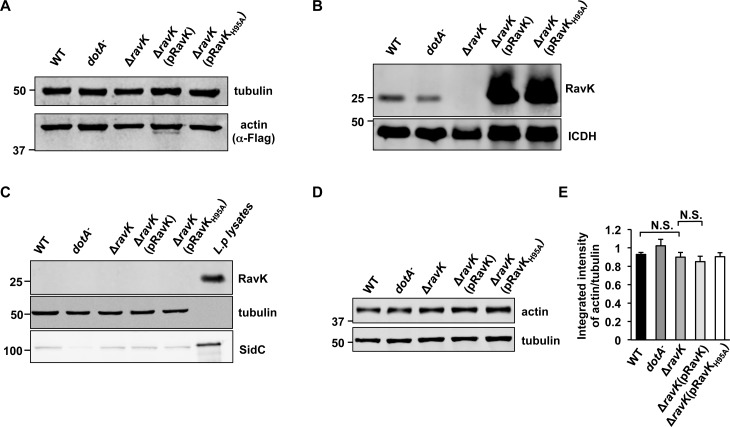
RavK-mediated cleavage of actin occurs during L. pneumophila infection.A. Actin is cleaved by translocated RavK during bacterial infection. Cells expressing Flag-tagged actin were infected with relevant L. pneumophila strains for 2 h and cleared cell lysates was probed by immunoblotting with a Flag specific antibody. Tubulin was probed as a loading control. Similar results were obtained from five independent experiments and a representative blot was shown. B. The detection of RavK expression in L. pneumophila. The lysates of WT and the dotA- mutant were from exponentially grown bacteria whereas those of other strains were from bacteria grown at the post-exponential phase; the metabolic enzyme isocitrate dehydrogenase (ICDH) was probed as a loading control. C. RavK cannot be detected in saponin-soluble fractions of infected cells with RavK-specific antibody. SidC, a known Dot/Icm substrate was probed as a positive control for translocation and tubulin was probed as a loading control. D. Cleavage of endogenous actin. Lysates of cells similarly infected as described in C were probed for actin with tubulin as a loading control (left panel). E. The ratio of intensity between the bands representing actin and tubulin was quantified from three independent experiments. Note that a reduction in actin was not observed even in infections using the RavK overexpressing strain. N.S., not significant.